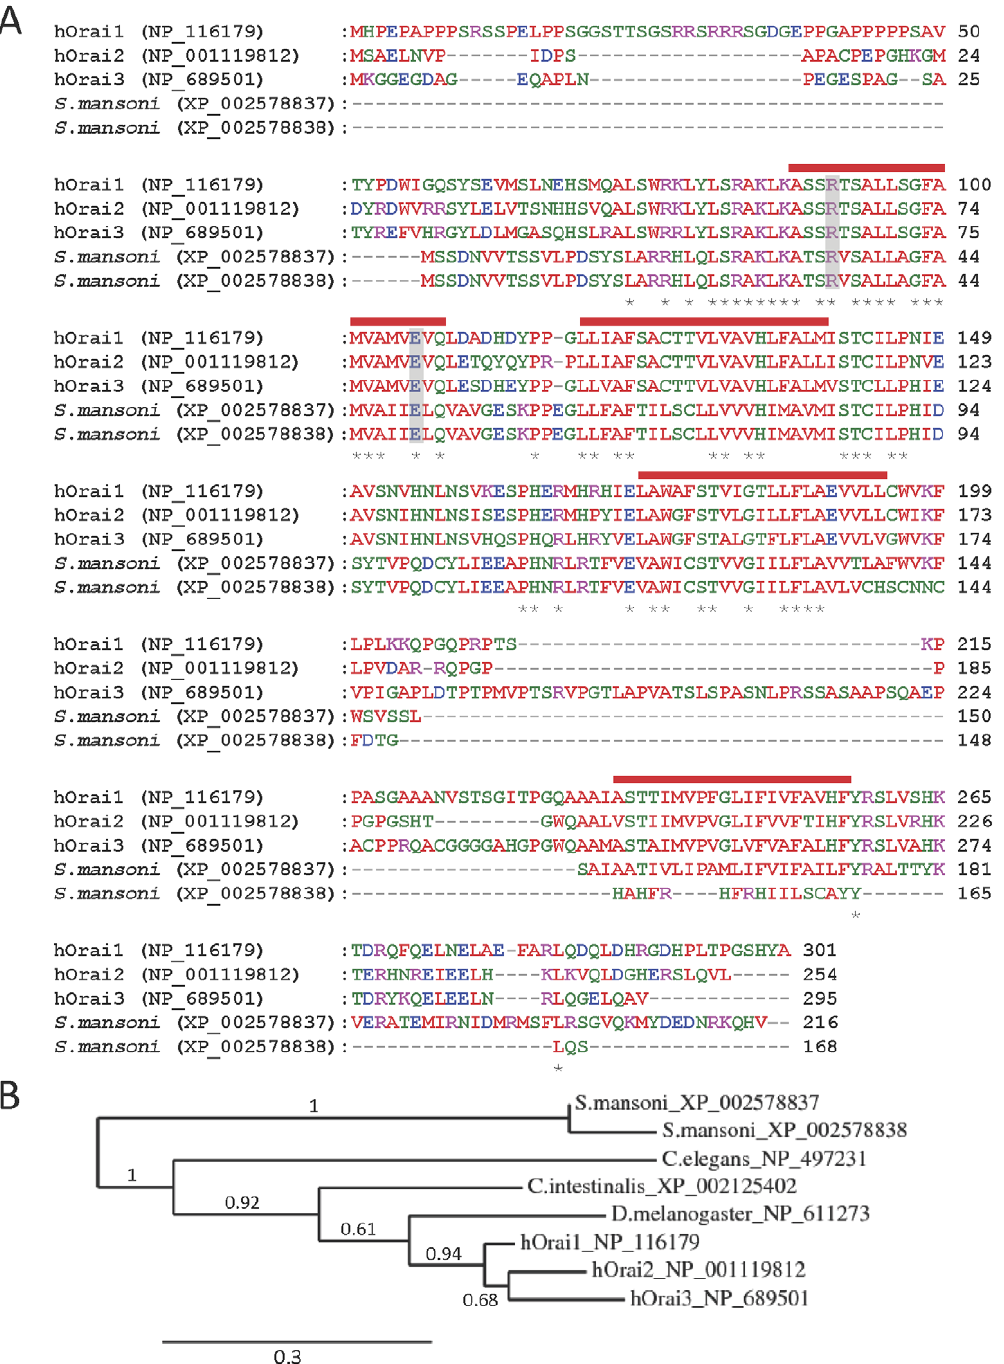
Figure 5. Comparison of human and S.mansoni Orai homologues. (A) Alignments of human Orai subunits with predicted homologues from S. mansoni are shown (XP_002578838 is a shorter alternatively spliced variant of XP_002578837). Residues within the putative pore that are crucial for hOrai1 function (R91 and E106) are highlighted by grey bars. Predicted transmembrane regions of hOrai1 are indicated by red bars above the alignment, and asterisks below the alignment denote sequence identity amongst all isoforms. (B) Phylogram showing the relationship between human and S. mansoni Orai homologues as well as those of the model invertebrates C. elegans, D. melanogaster and C. intestinalis (see Methods: based on 141 high confidence positions from a multiple sequence alignment; gamma shape parameter 1.541; proportion of invariant sites 0.156) . Branch length scale bar and branch support values are shown.